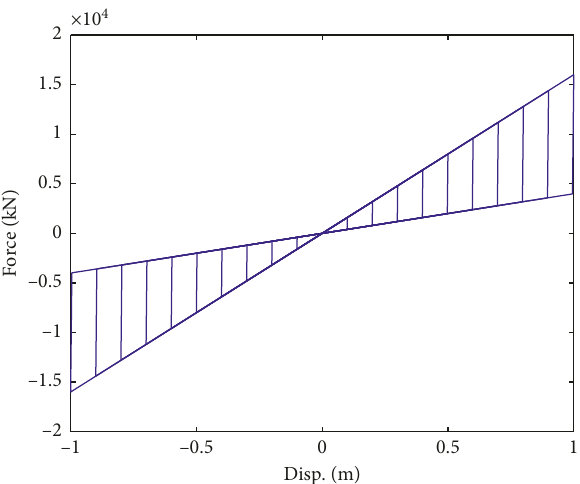
Figure 11: Test result of Reid element